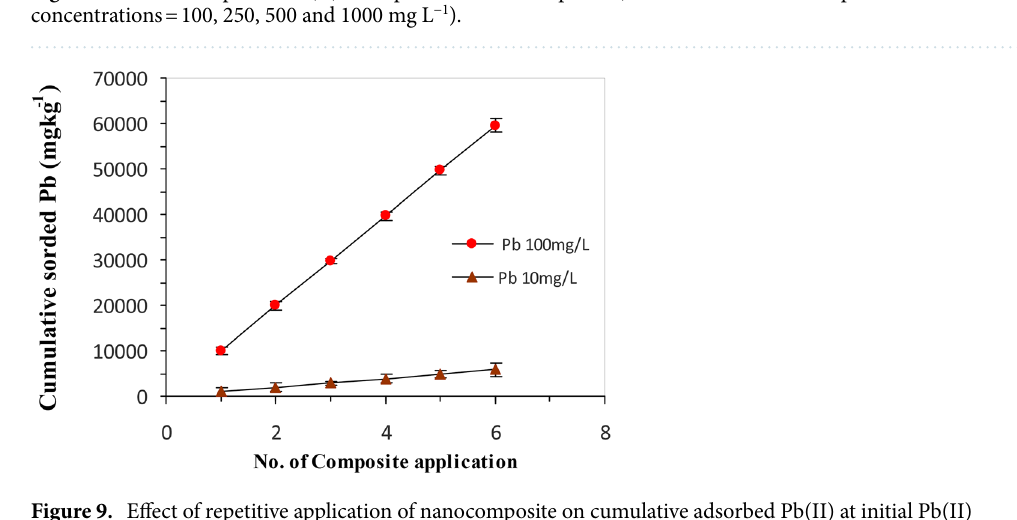
Figure 9. Effect of repetitive application of nanocomposite on cumulative adsorbed Pb(II) at initial Pb(II) concentrations of 10 and 100 mg L − 1